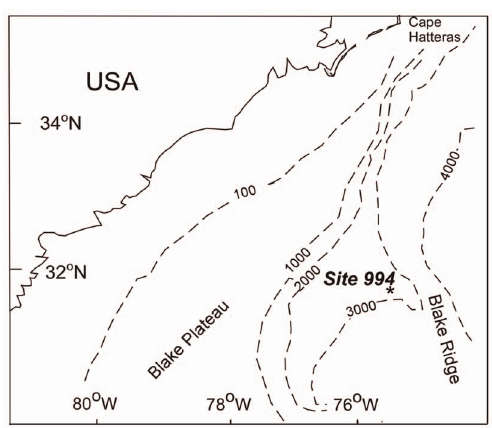
Figure 1. The location of ODP Hole 994C, Blake